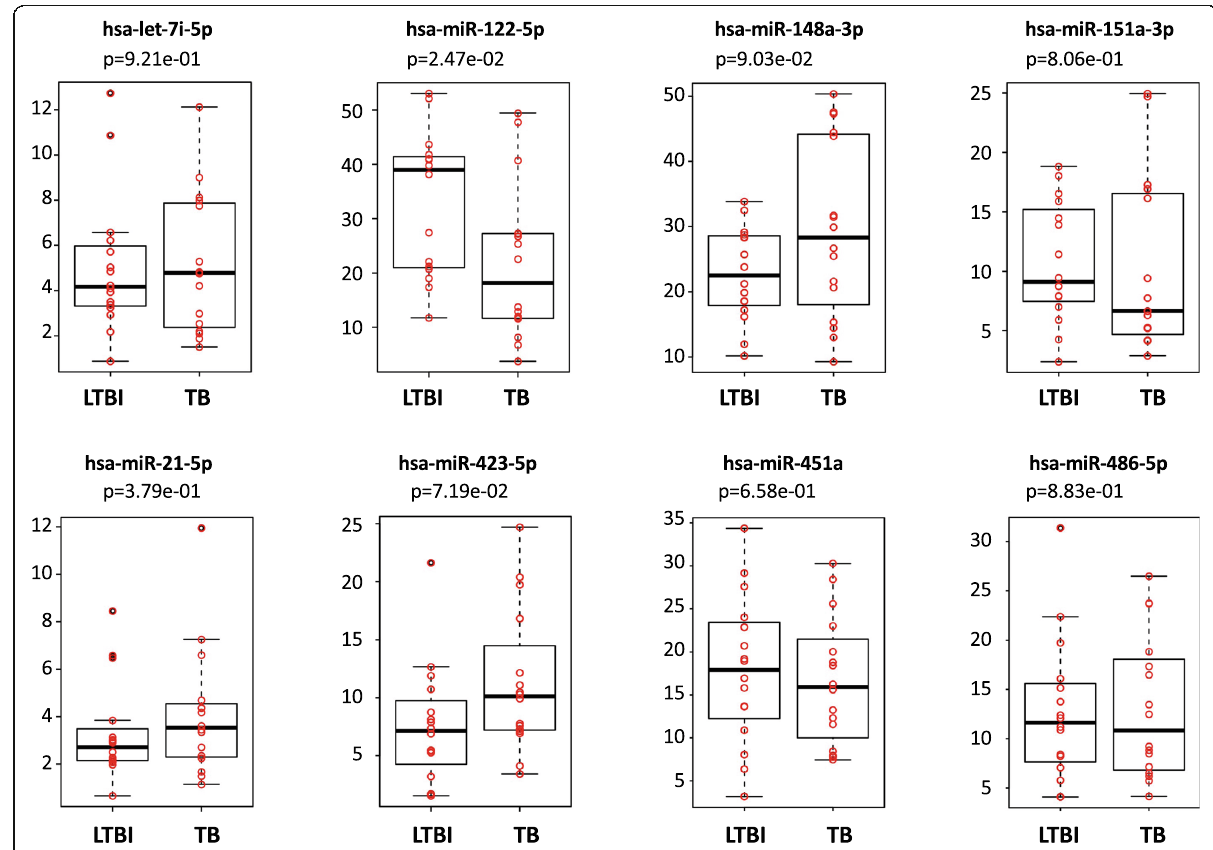
Fig. 1 Expression pattern of the nine miRNAs used in the diagnosis of active TB/LTBI. The vertical axis shows the relative expression level of miRNA, and the dots represent the relative expression levels in